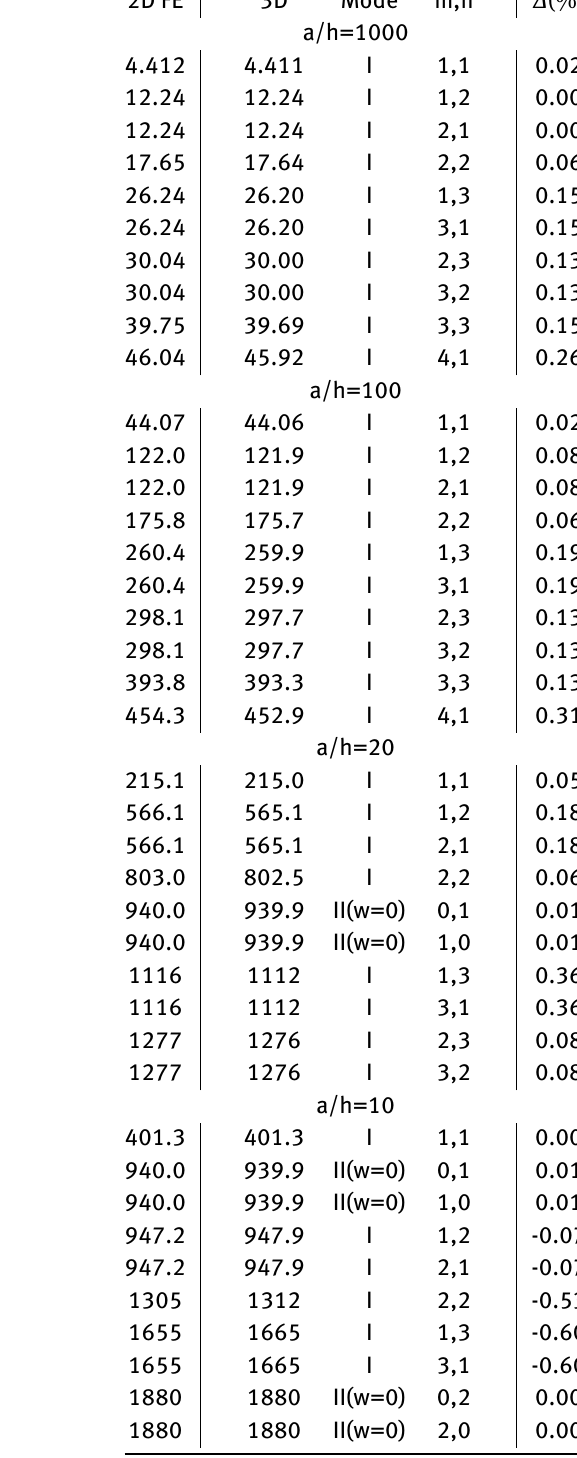
Table 15: Eighth benchmark, simply supported composite cylinder 90 ∘ /0 ∘ /90 ∘ with thickness ratios R α /h=1000, R α /h=100, R α / h = 10 and R α /h=5. First ten frequencies in Hz, comparison between the present 3D exact solution and the 2D FE solution via Nastran.